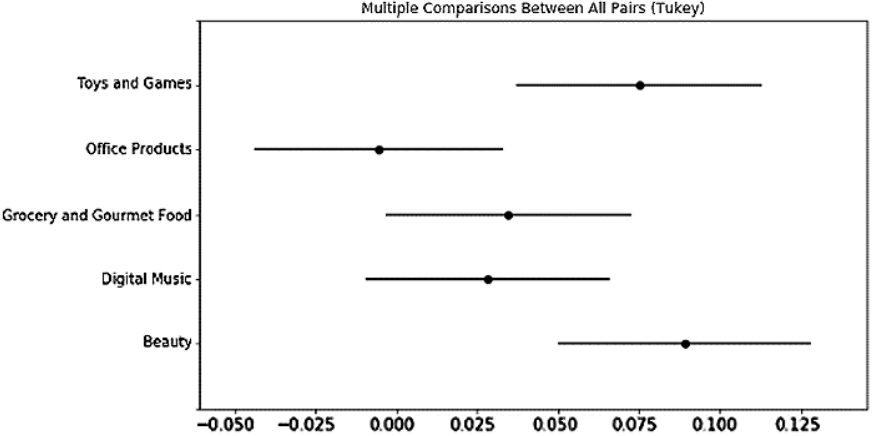
Figure 8. Multiple comparisons between all pairs (Tukey) in product categories for psychographic variable segmentation-based rating prediction (RMSE).